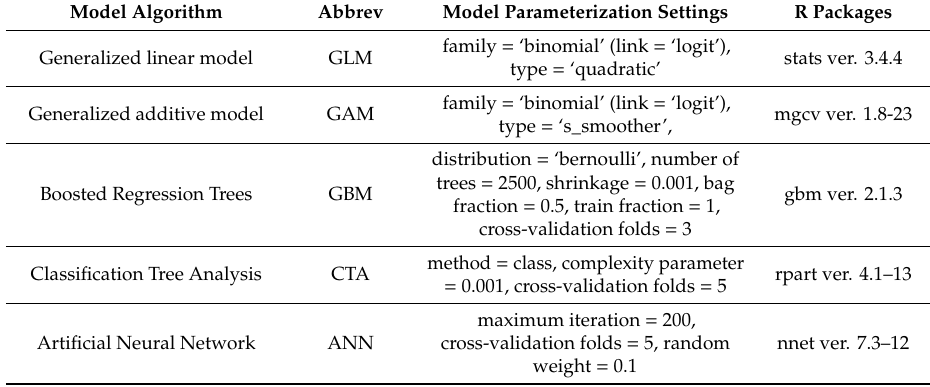
Table 1. List of the species habitat models and the parametrization settings used to generate the summer potential squid habitat in the study area, available through the BIOMOD2 package version